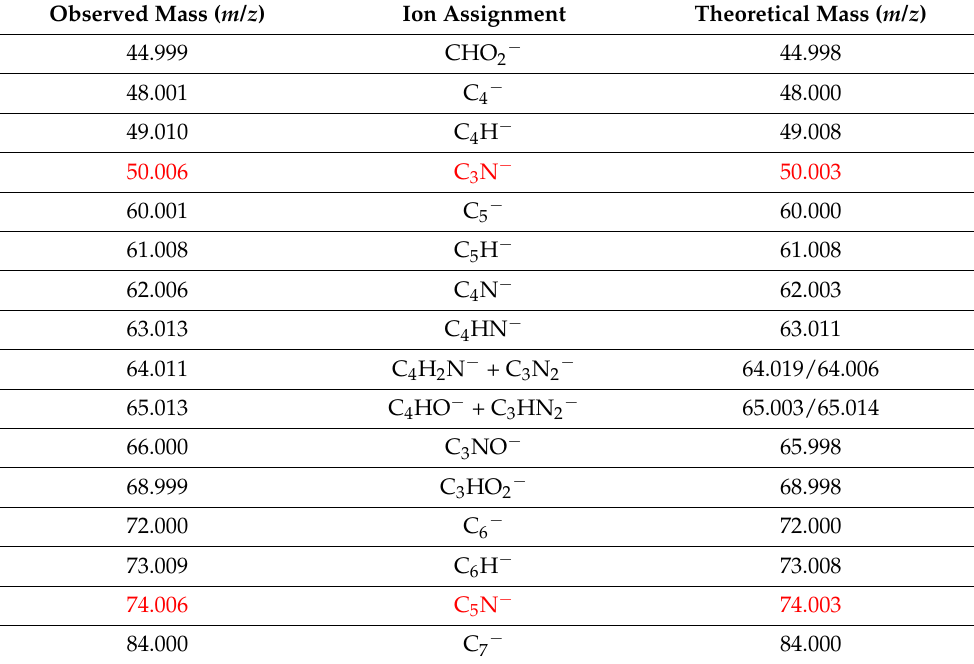
Figure 3. Negative-ion time-of-flight secondary ion mass spectrometry (ToF-SIMS) spectra of DHI + DHICA (1:1) melanin, untreated and after mild and harsh maturation, respectively. Specific ion assignments are listed in Table 2 and spectra for the DHI and DHICA melanins can be found in the Supplementary materials Figure S1. Table 2. Major peaks and ion assignments in negative-ion ToF-SIMS spectra of eumelanins. Observed mass values are given for DHI + DHICA (1:1) eumelanin after harsh experimental maturation, but similar values were observed also for the other samples. Peaks assigned to C (2n − 1) N − ions are printed in red to highlight the repetitive nature of the spectra.